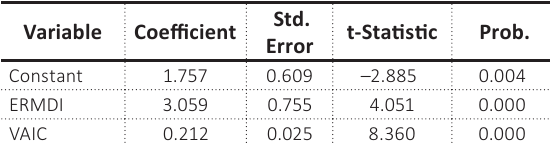
Table 5. Random effect model